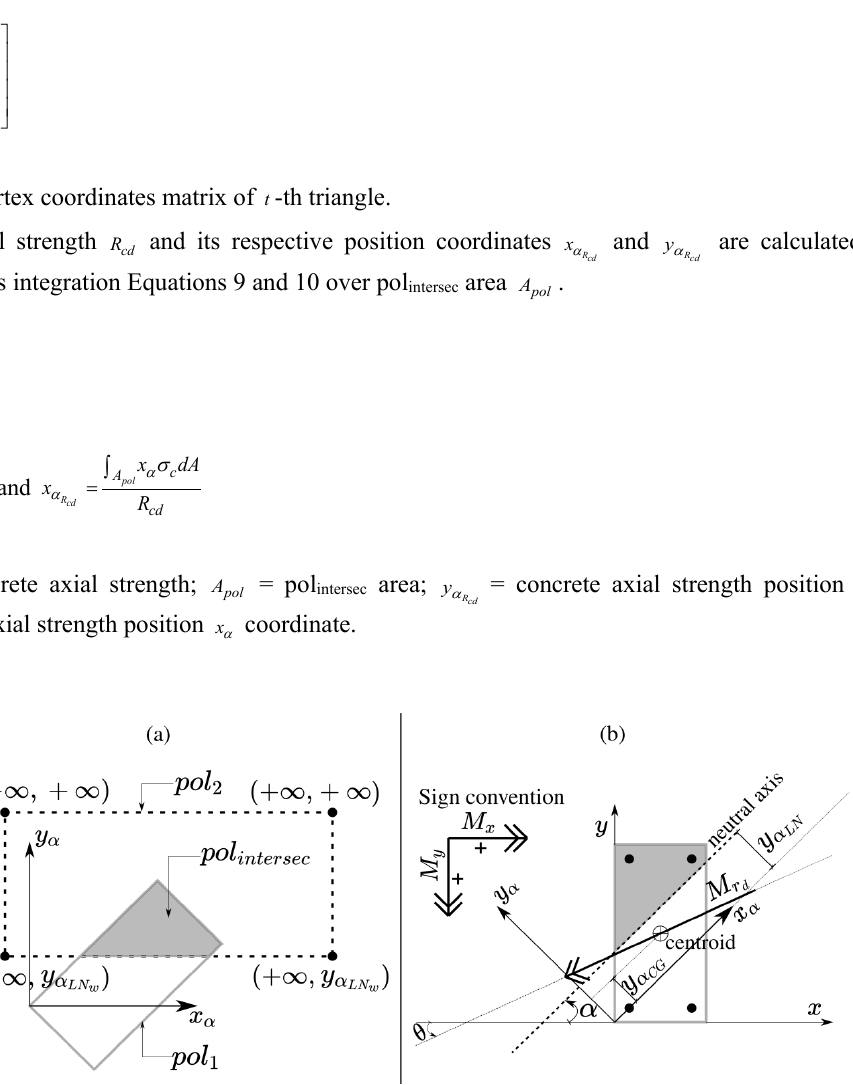
Figure 5. (a) Polygon intersection demonstration; (b) Difference between neutral axis angle α and flexural strength angle θ .